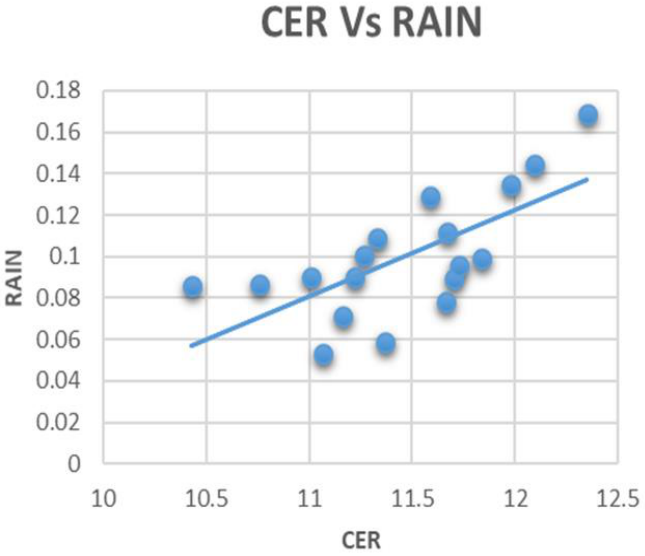
Figure 7. Scatter plot of CER vs. rainfall over Asmara in JJA that shows the correlation plot of highlighted bold values given in Table 7. Table 8. The correlation coefficient values between AOD, rainfall, AAI, CER, and COT over Assab in JJA between 2001 and 2018. The correlation coefficient (R) value ≥ 0.468 (critical R−value) is highlighted in bold.